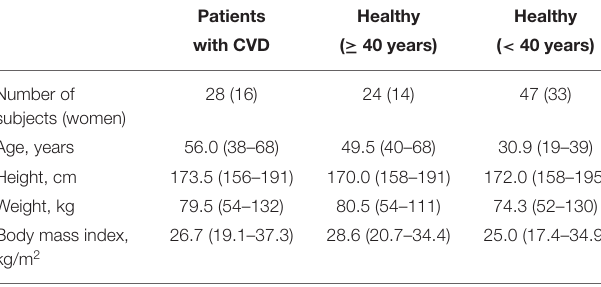
TABLE 1 | Subject characteristics in three